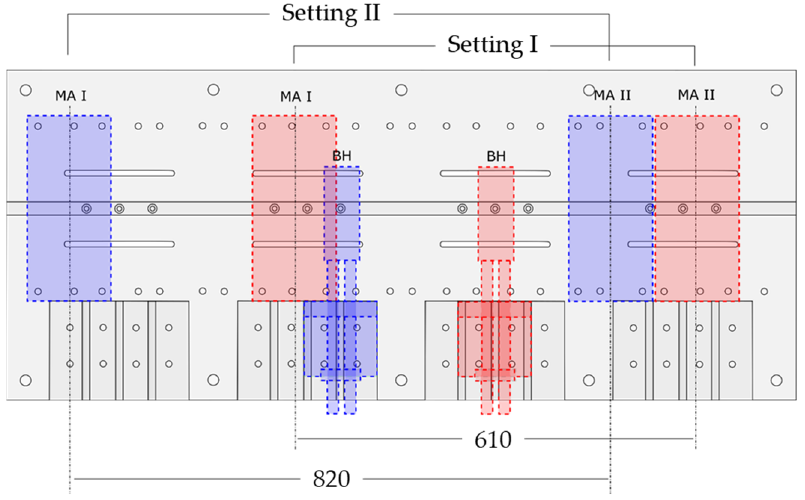
Figure 11. Two possible configurations for mounting the magnetic actuators (MAs) and bearing housing (BH).